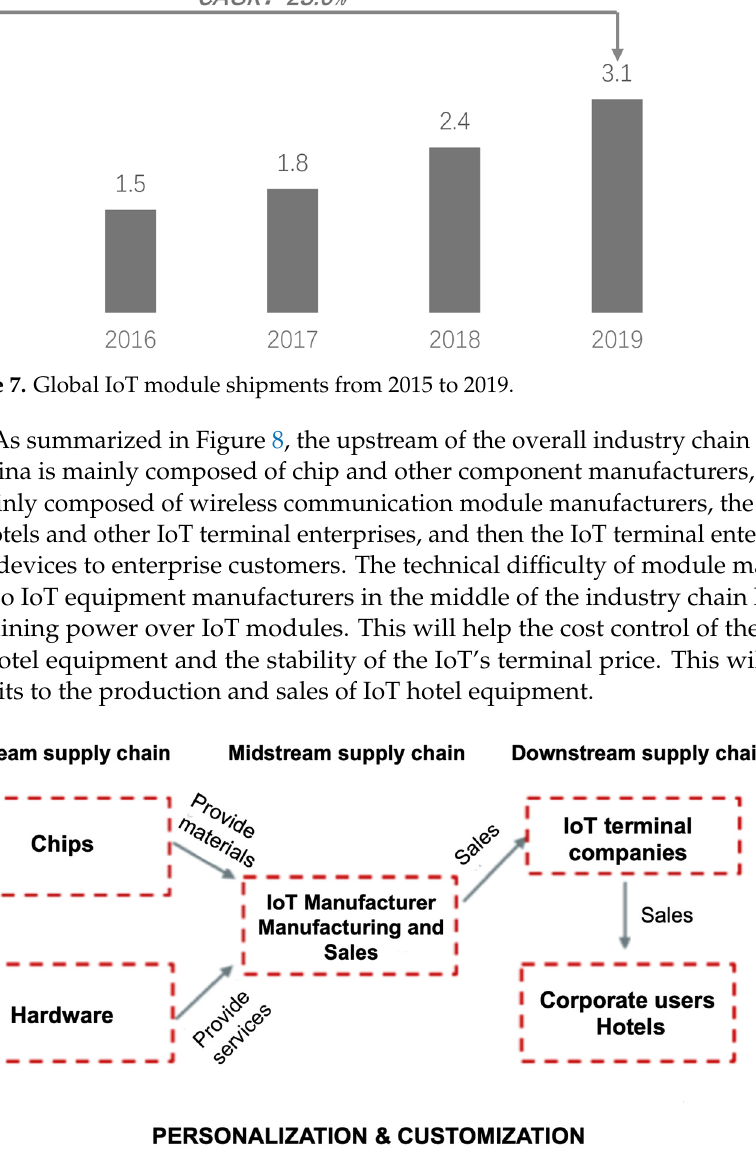
Figure 8. IoT module business model in China.